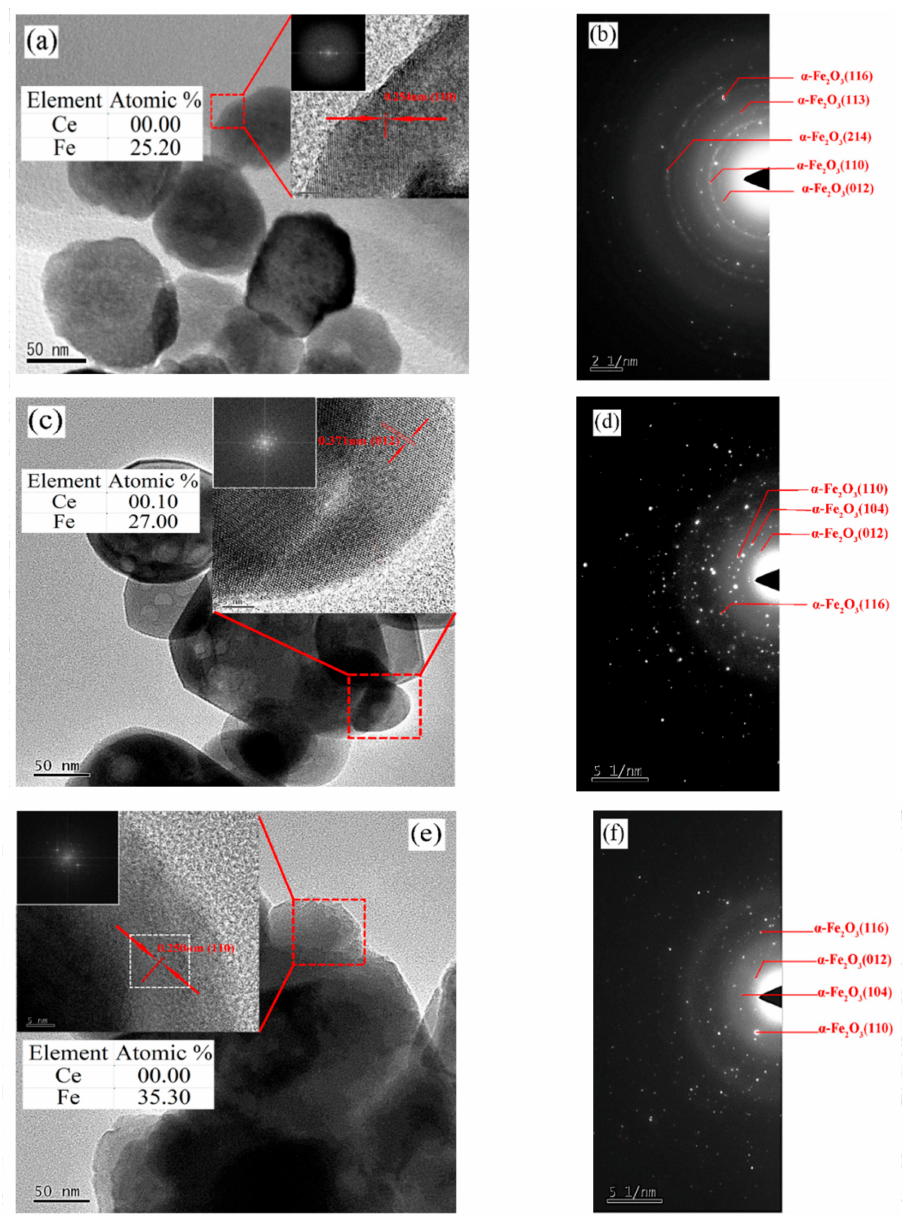
Figure 4. TEM (transmission electron microscopy) images of samples. ( a,b ) Undoped α -Fe 2 O 3 sample; ( c,d ) Ce-doped α -Fe 2 O 3 sample; ( e,f ) Bayer α -Fe 2 O 3